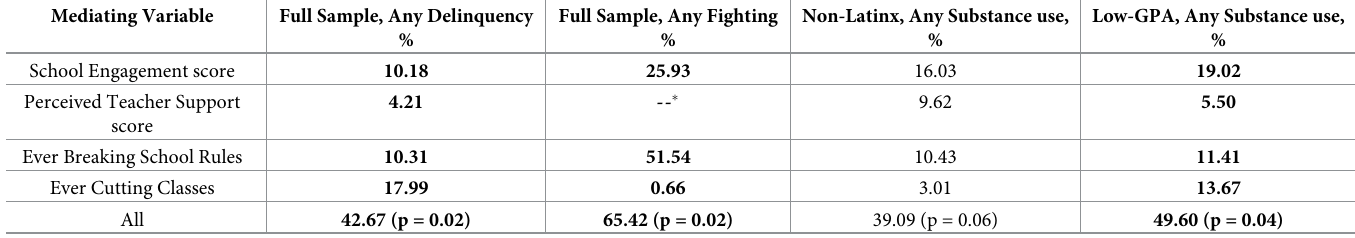
Table 4. Estimated percent of associations between gender stigma awareness and risky health behaviors mediated by school